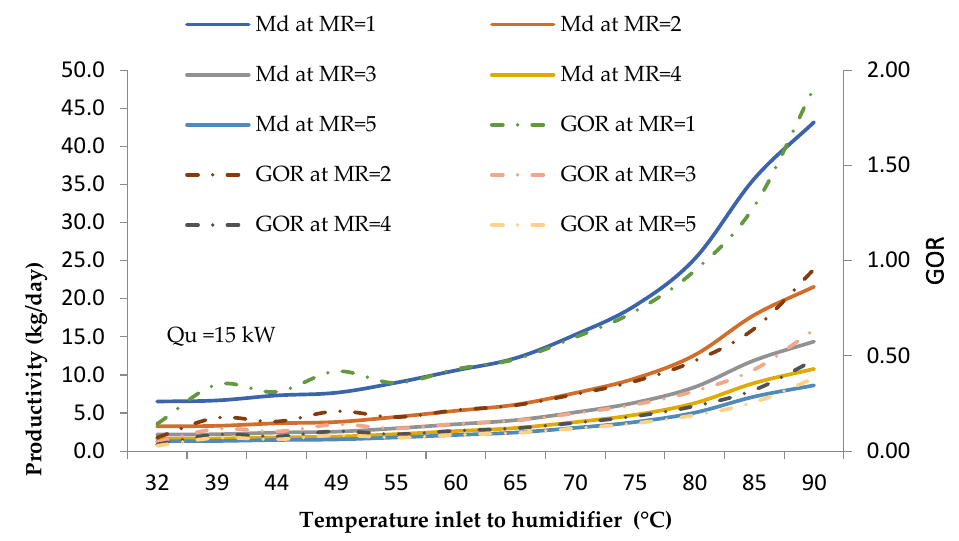
Figure 11. Effect of feed water temperature entering to the humidifier on productivity and GOR. The recovery ratio (RR) is defined as the ratio of mass flow rate of product water to the mass flow rate of feed water as given by Equation (A9 in Appendix A). As shown in Figure 12, the recovery ratio decreases when the flow of feed water increases. At constant head load, increasing the flow of feed water into the system reduces the recovery ratio. This is because the ability to distill freshwater from saltwater depends on heat load.